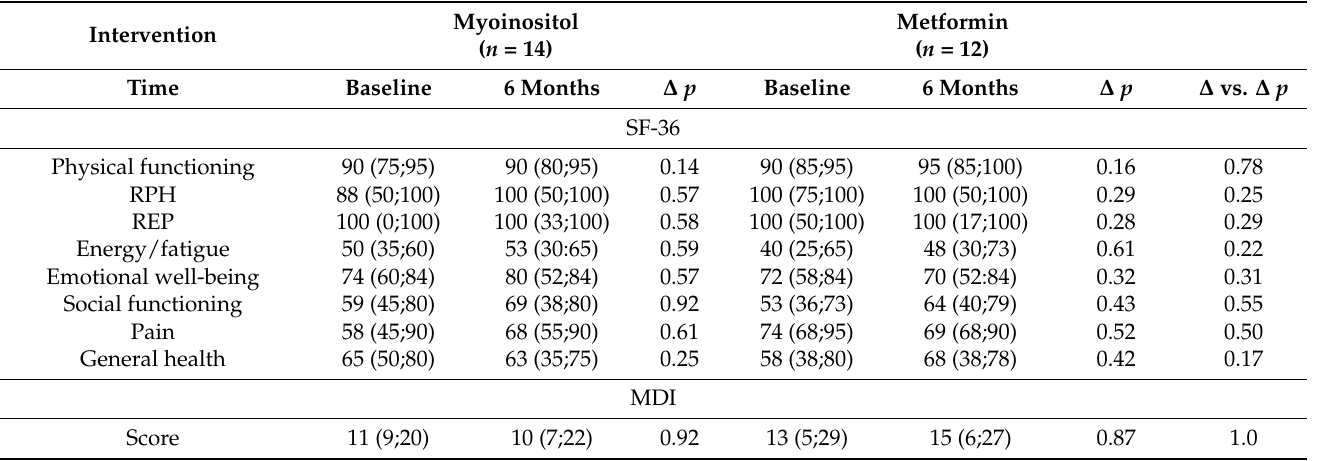
Table 2. Baseline characteristics and changes after 6 months in the myoinositol and metformin